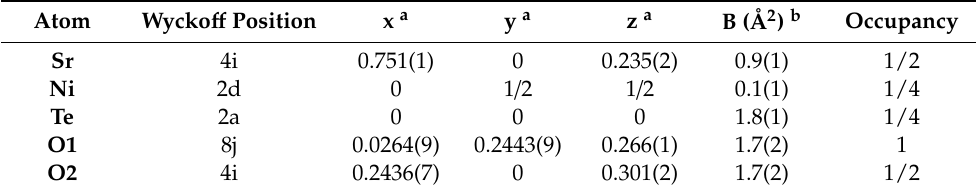
Table 2. Structural parameters for Sr 2 NiTeO 6 extracted at room temperature (292 K). The site occupancies are expressed in terms of the ratio m:M—site multiplicity:multiplicity of a general position (8).